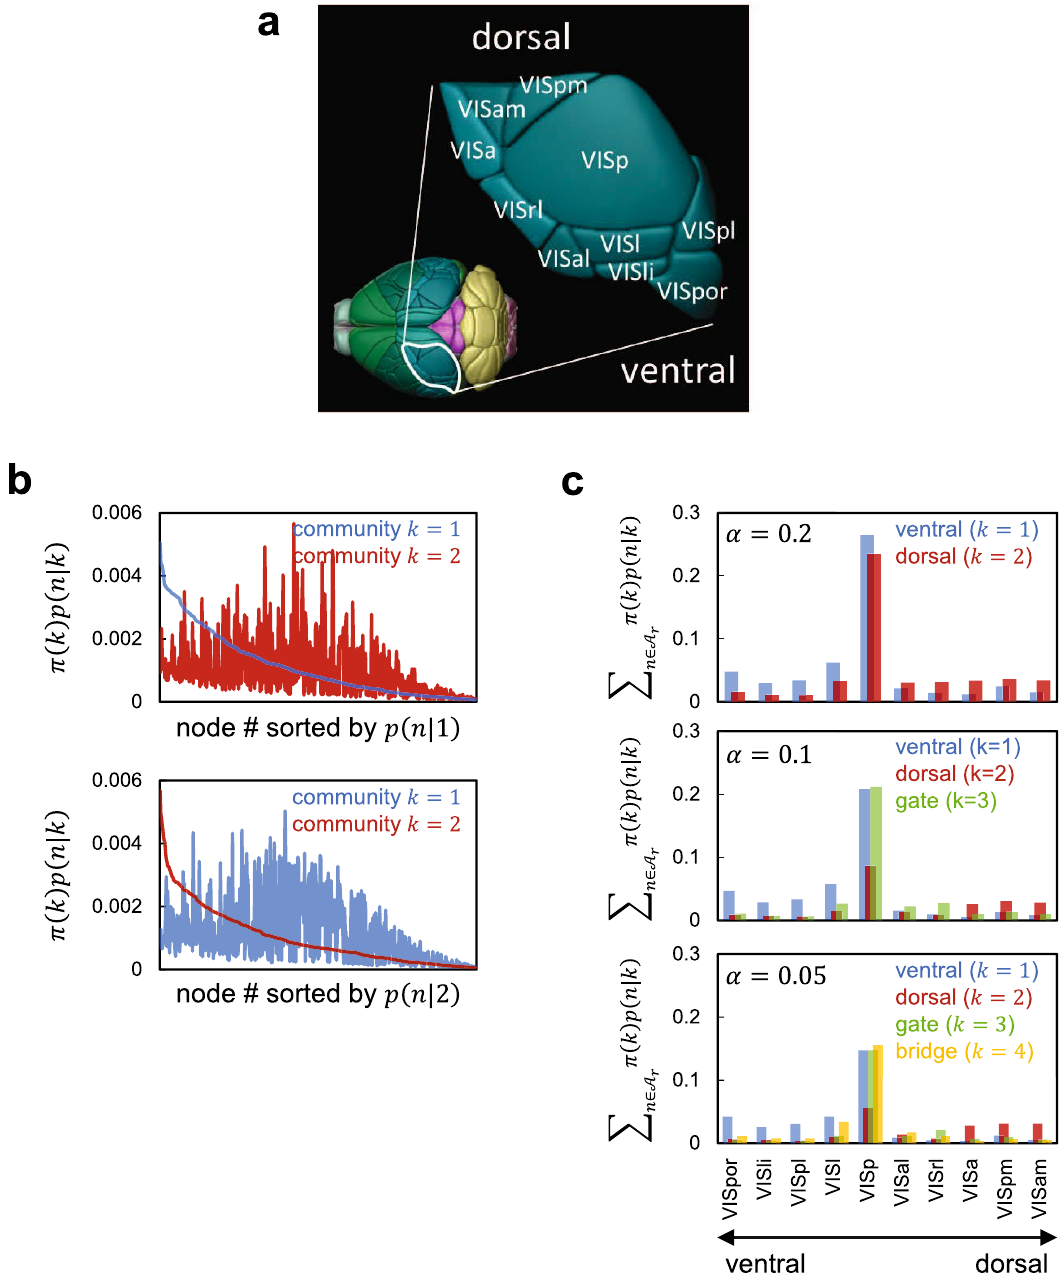
Figure 4. ( a ) Mouse visual cortex and its 10 areas, traced by Brain Explore (https:// mouse. brain- map. k ) of detected two communities (say, org/ static/ brain explo rer). ( b ) The probability distributions π( k ) p ( n | 1 (blue) and community k 2 (red)) for α 0.2 . In the top and bottom panels, the node community k = = = number (#) is sorted in the descending order of p ( n |1) and p ( n |2), respectively. ( c ) The probability distributions 0.2 , 0.1, and 0.05 are shown in the top, middle, and of communities detected from the network for α = bottom panels, respectively. The ordinate value represents the probability at each area obtained by calculating A 1, . . . , 10 ) symbolize the areas listed along the A r π( k ) p ( n | k ) , where r ( r = n ∈ (cid:31) communities obtained for α = 0.2. In the third one (green), which is seemingly separated from the dorsally biased community, most probability mass is concentrated around VISp. The third community is likely to gate the visual cortex. For α = 0.05, the fourth one (yellow), seemingly separated from the ventrally biased community, emerges (Fig. 4c, bottom). Besides high concentration around VISp, probability mass of the fourth community also substantially resides around VISl and VISal. We suppose that the fourth community serves as a bridge between the ventral and dorsal pathways. Interestingly, an experimental study 50 demonstrated that a dorsal part of VISp projects to the VISl/VISal border while a ventral part projects to two separated patches (namely, VISl